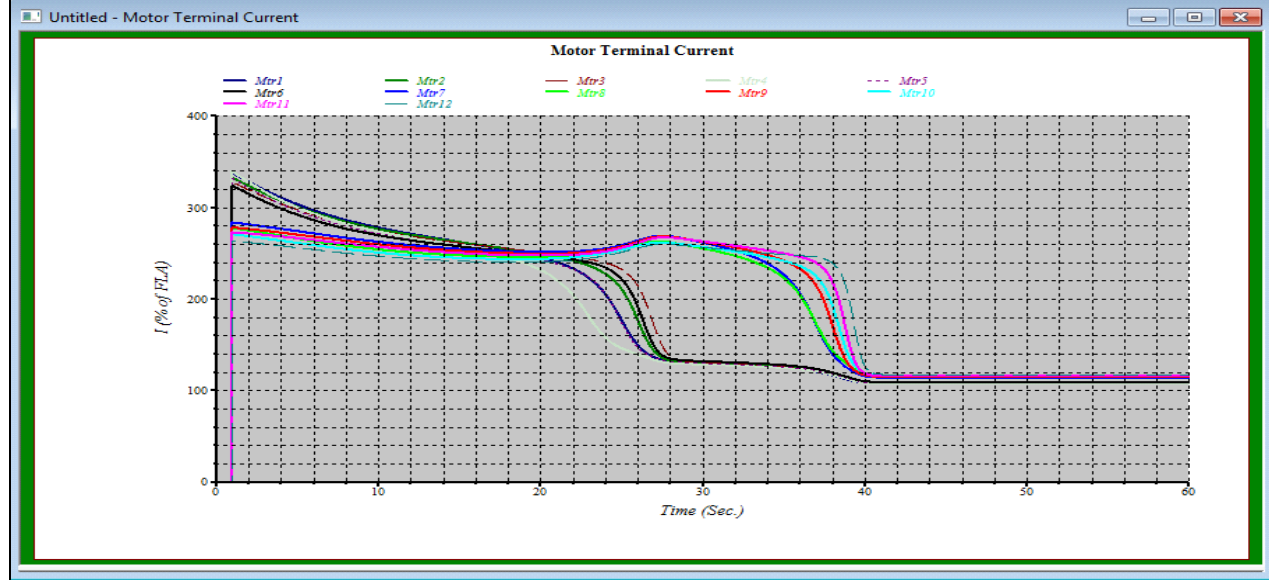
Figure 4: The starting current of the motors as a function of time.